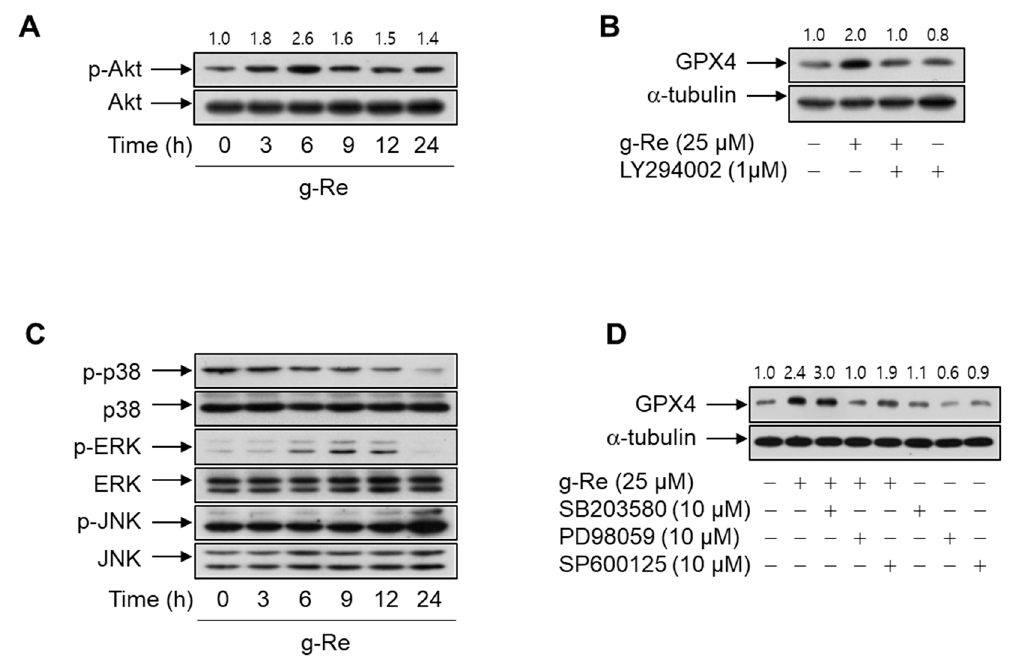
Figure 7. Roles of the phosphoinositide 3-kinase (PI3K) / Akt pathway and mitogen-activated protein kinase cascades in ginsenoside Re (g-Re)-induced upregulation of GPX4. ( A , C ) SH-SY5Y cells were treated with 25 µ M of g-Re for the indicated durations. An aliquot of the whole-cell lysate was immunoblotted with activation-specific antibodies, while total kinase levels were analyzed in parallel immunoblots. ( B , D ) SH-SY5Y cells pretreated with vehicle (Dimethyl sulfoxide), LY294002, SB203580, PD98059, or SP600125 for 1 h were incubated with or without g-Re for 24 h. The level of GPX4 protein was assessed by Western blot analysis. α -Tubulin was used as an internal control for immunoblotting.